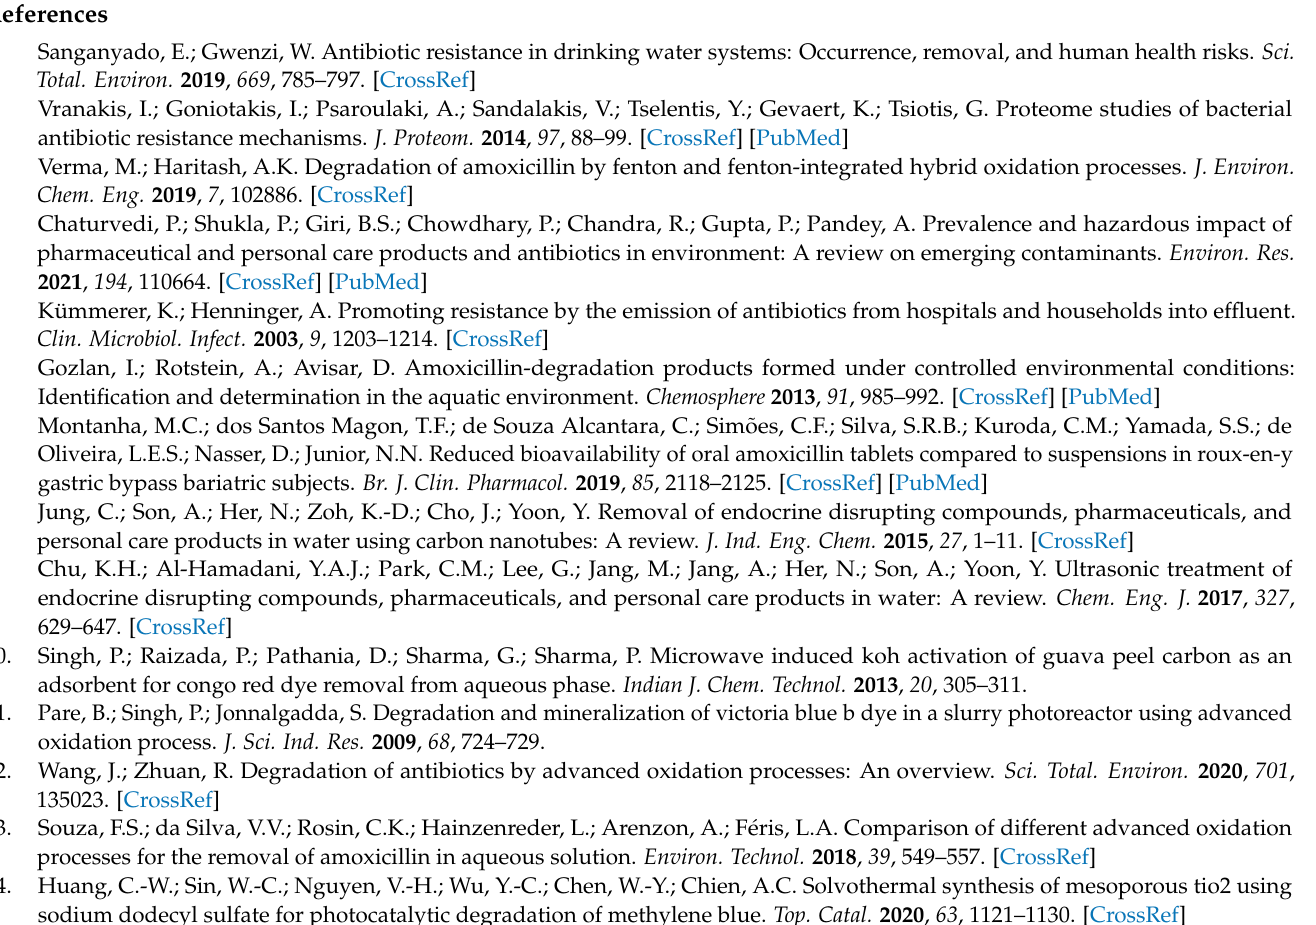
Figure S3. FTIR spectra of various ZnTiO 3 prepared by various conditions; Figure S4. (a)–(d) and (d)-(f) the SEM images at the magnification of 10,000 × and 30,000 × of ZnTiO 3 -N750, ZnTiO 3 -N1500, and ZnTiO 3 -3000; Figure S5. the SEM images at the magnification of 30,000 × of (a) ZnTiO 3 -P3 and (b) ZnTiO 3 -P5; Figure S6. N2 adsorption-desorption isotherms of ZnTiO 3 prepared various NH 4 OH and PVP modification; Figure S7. UV-Vis result of ZnTiO 3 prepared by various amounts of NH 4 OH and PVP modification; Figure S8. The changes of C/C L0 with reaction time (a) for various amounts of NH 4 OH addition and (b) for various amounts of PVP addition; Figure S9. The changes of C/C 0 with reaction time by using P25 and ZnTiO 3 -700 ◦ C; Table S1. the comparison of activities over different photocatalysts to degrade